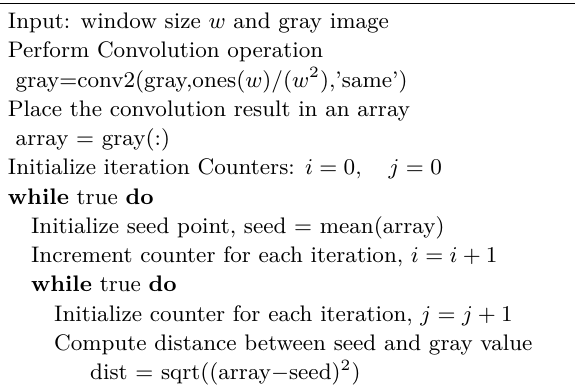
Algorithm 2 Pseudocode for modified adaptive k